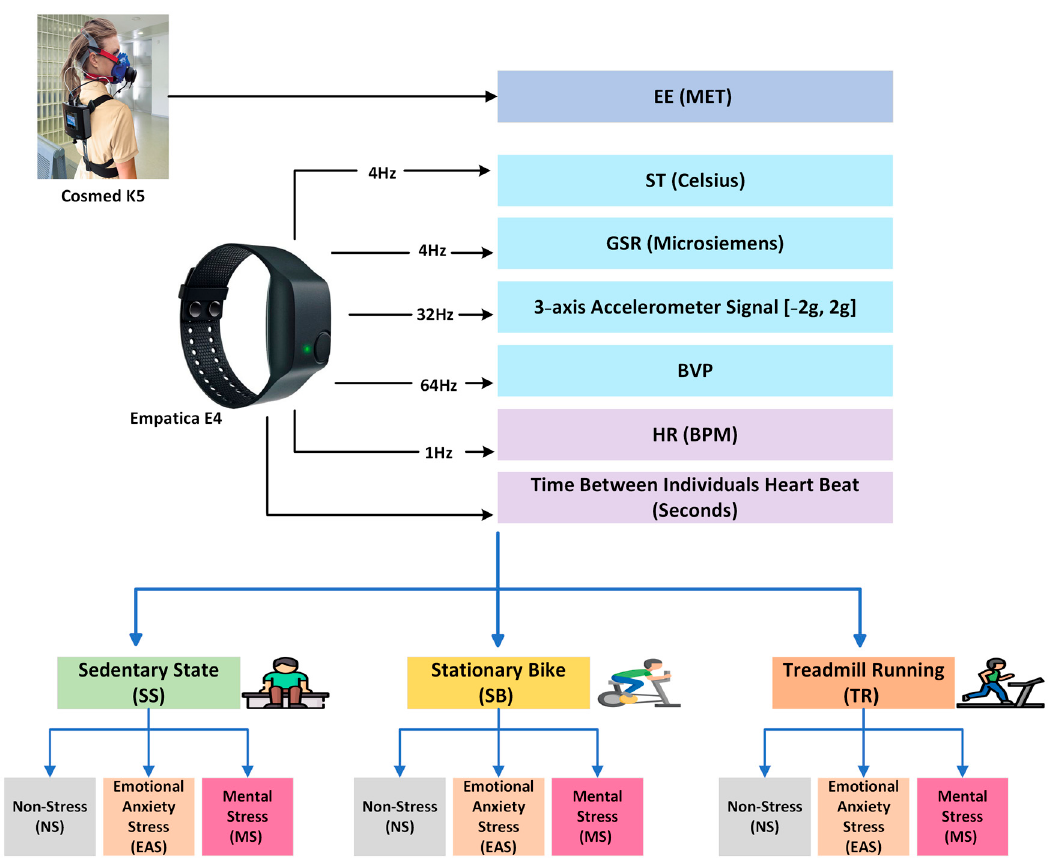
Figure 1. A schematic representation of the data acquisition system for the data